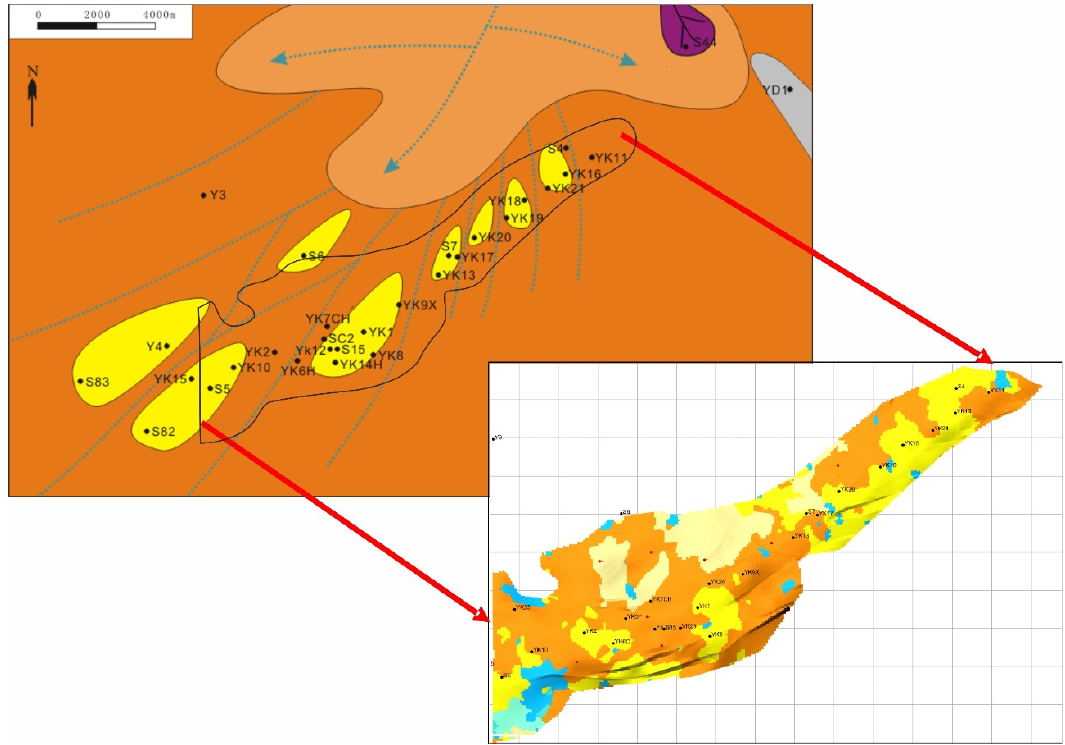
Figure 13. Comparison between the probability simulation results and the petrophysics determined facies model of the upper member of K 1 y in Yakela area.